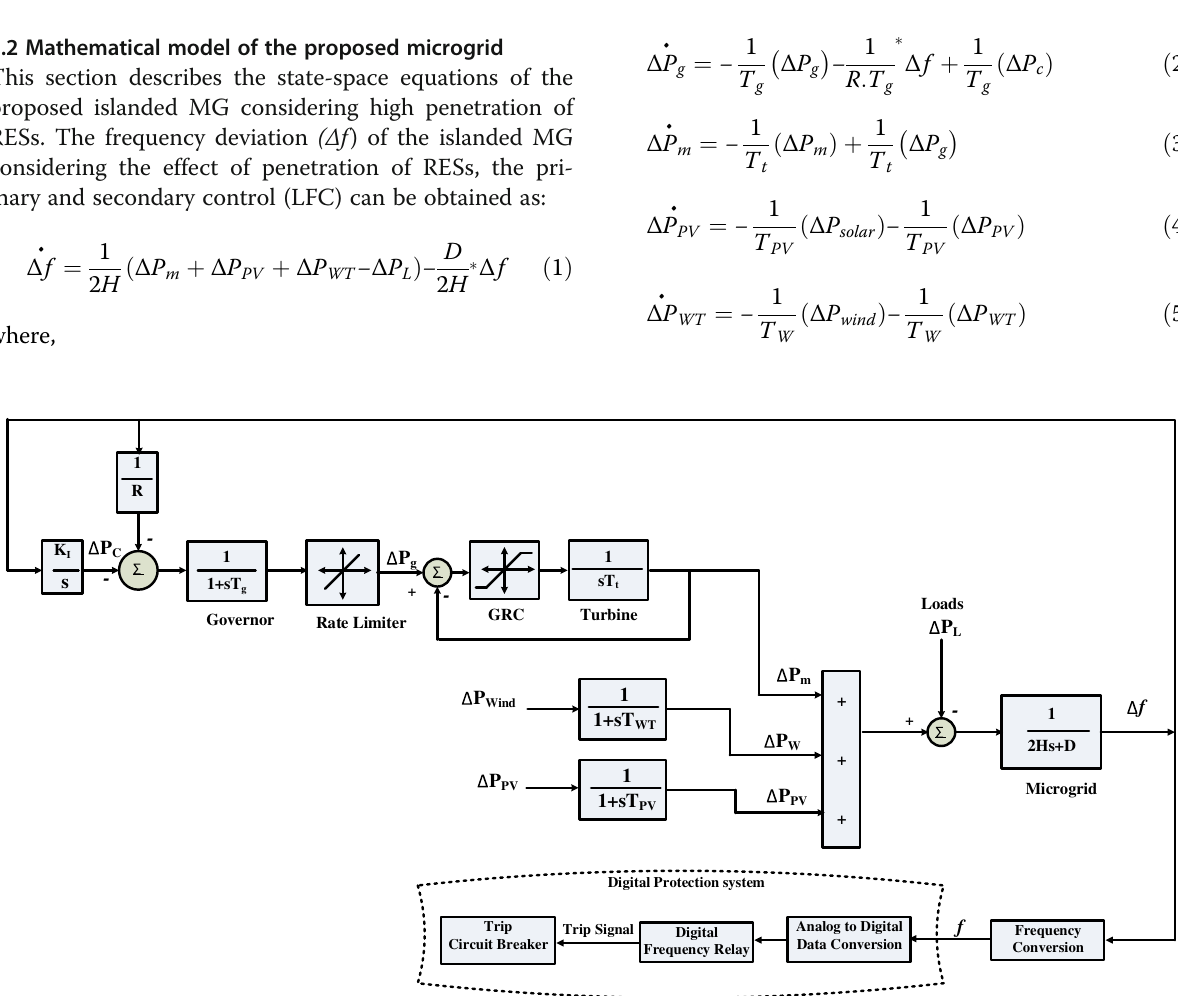
Fig. 3 The dynamic model of the islanded microgrid with the proposed coordination